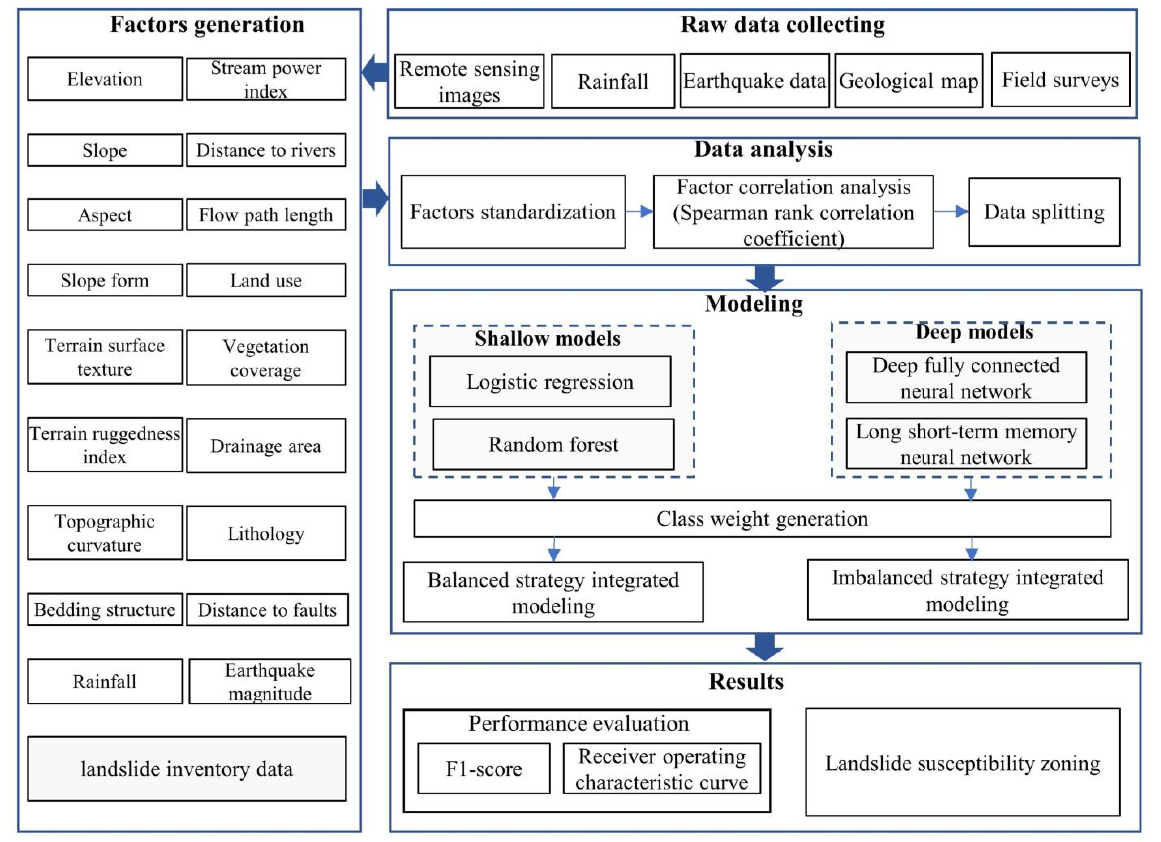
Figure 3. Methodological flowchart of the study.